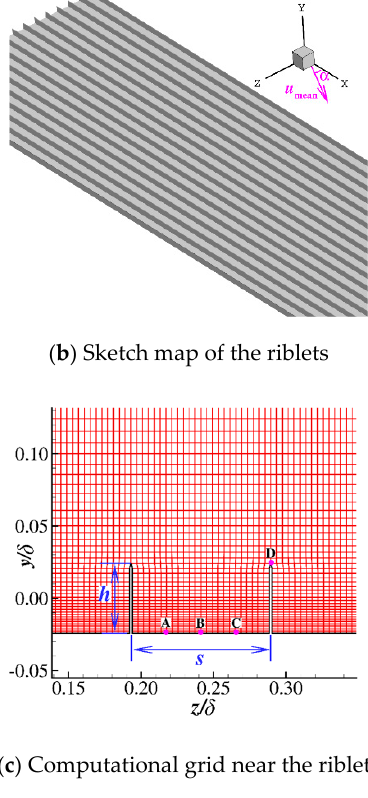
Figure 1. Sketch map of the blade-type riblets and the grid near the riblets.